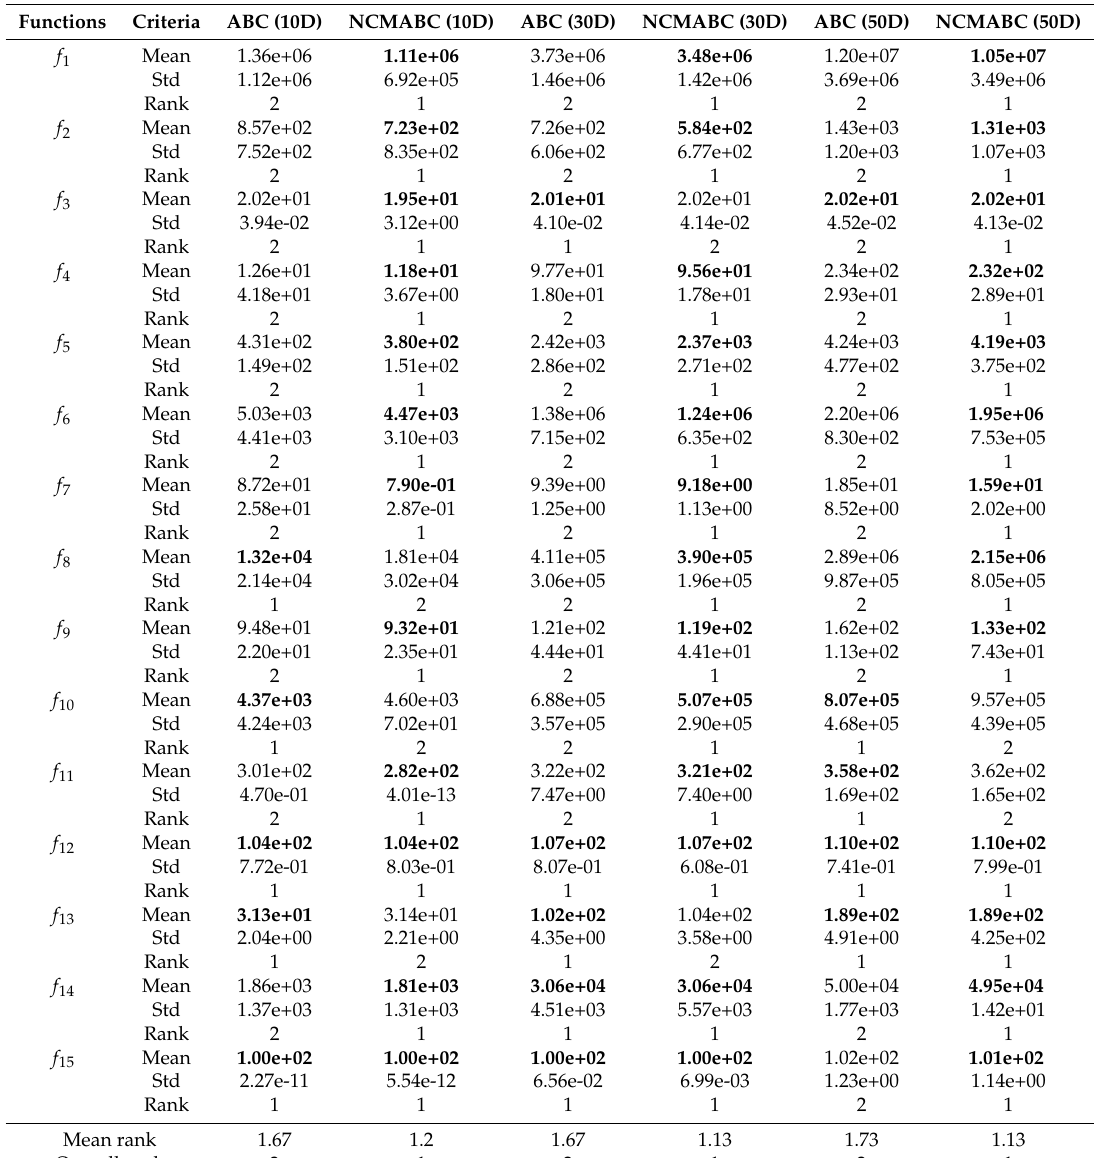
Table 1. Experimental Results between ABC with the new choice mechanism (NCMABC) and the basic